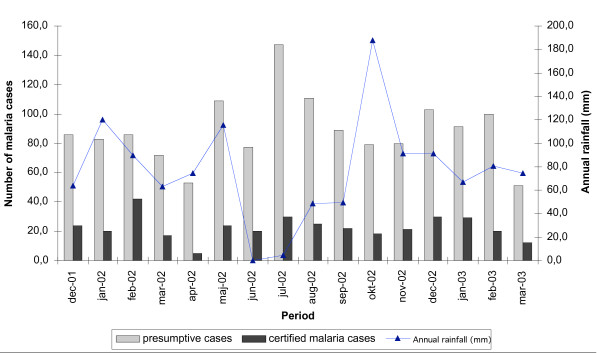
Relationship between presumptive and certified malaria cases and rainfall in Kabale district during the period December 2001 to March 2000.